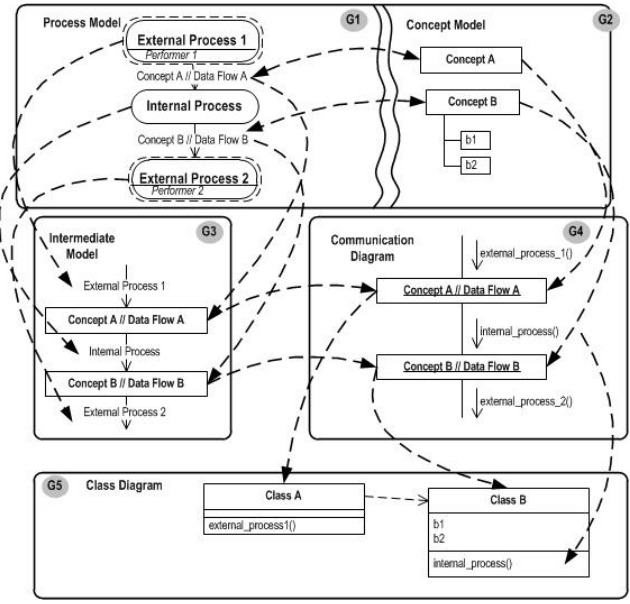
Fig 3. The essence of the two-hemisphere model transformation. In correspondence with [16] the transformation is the automatic generation of a target model from a source model according to a transformation definition. In the case of BrainTool, the source model is the two-hemisphere model consisting of the process diagram, the set of concepts and linkage of the concept to the data flows. The target is the UML class diagram, which is a set of classes, class methods, class attributes, interfaces and relationships between classes and